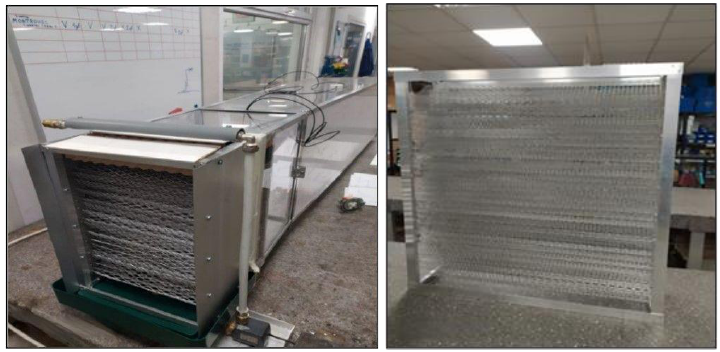
Figure 4. The testing setup.